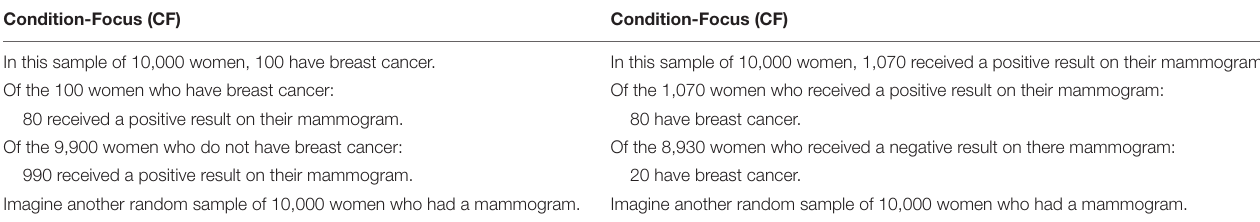
TABLE 2 | Example condition-focus and test-focus presentations of the mammography problem. Condition-Focus (CF) Condition-Focus (CF)